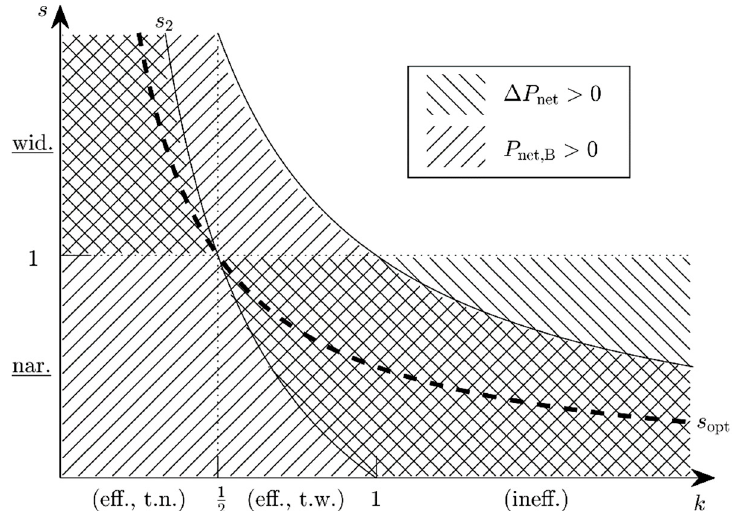
Figure 8. Regions in the s - k -domain for which the condition Δ P net >0 is satisfied (hatched from northwest to southeast) and for which the condition P net,B >0 is satisfied (hatched from southwest to northeast). The crosshatched region marks all parameter combinations associated with an energy harvester the energy output of which may be improved by ABS. The optimum performance is achieved for parameter combinations on the dashed line marked with s opt .